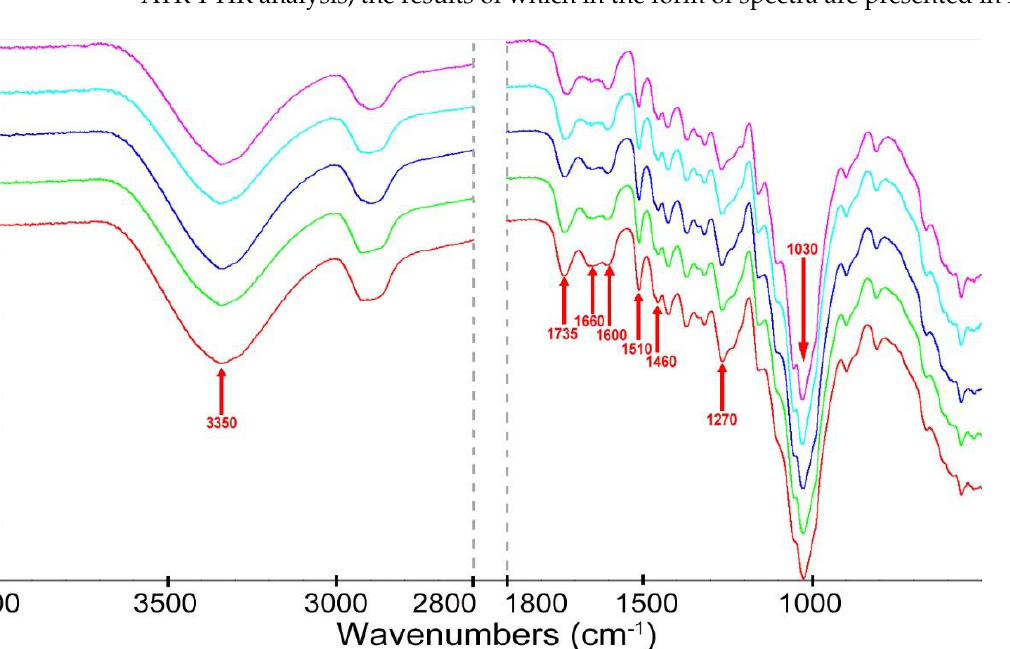
Figure 6. Content of extractives and main components in modified wood.